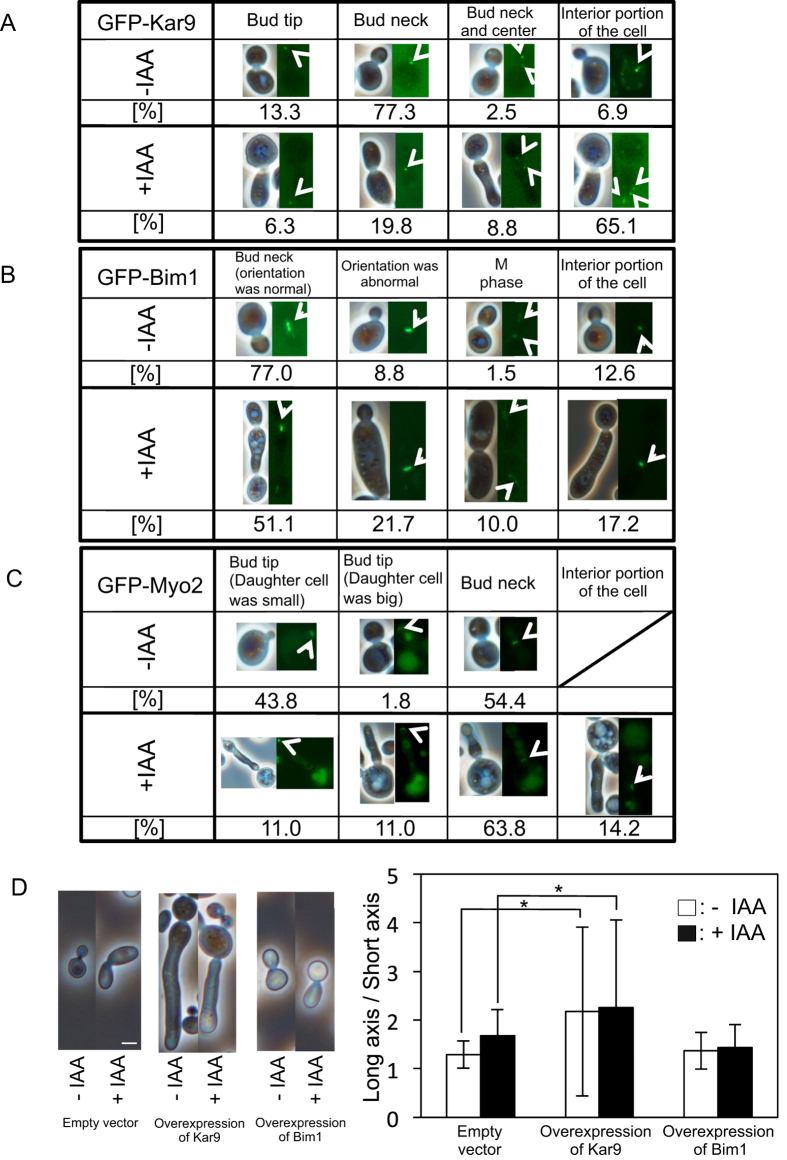
Localization of Kar9, Bim1 and Myo2, and cell morphology of Kar9- and Bim1-overexpressing cells.(A–C) EY0986/GFP-Kar9, EY0986/GFP-Bim1, or BY24051 cells for visualization of Kar9, Bim1, or Myo2, respectively, were incubated with (+IAA) or without (-IAA) 0.5% IAA for 8 h. The proteins were visualized based on fluorescence derived from GFP-fusion proteins. More than 200 cells were selected at random, from budded cells in treatment without IAA or from elongated cells in treatment with IAA. The cells were observed and then classified. Arrows indicate localization sites of GFP-fusion proteins. (D) pYES2 empty vector-harbouring and Kar9- and Bim1-overexpressing cells were incubated in SG medium with (+IAA) or without (-IAA) 0.25% IAA for 24 h. (Left panel) Morphologies of representative cells are shown. Bar, 4 μm. (Right panel) The lengths of long and short axes of randomly selected cells were measured. Data are means ± standard deviations of triplicate experiments. In each experiment, the budding cells were randomly selected (n > 200). *P < 0.05 vs. empty vector.